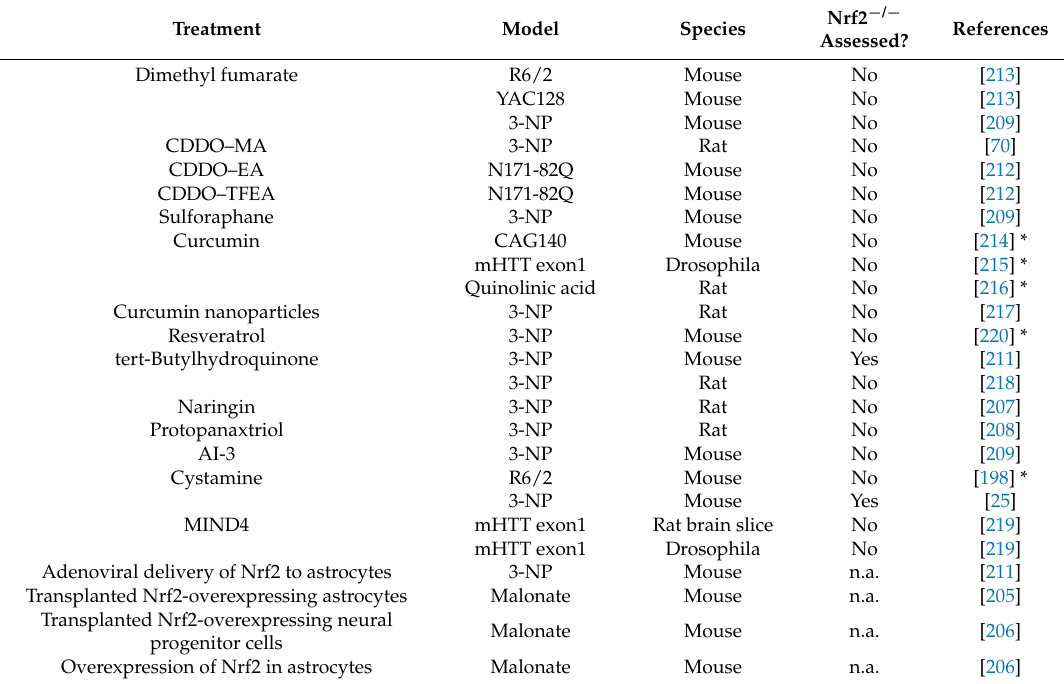
Table 6. Preclinical studies on Nrf2 activation in animal models of Huntington’s disease.